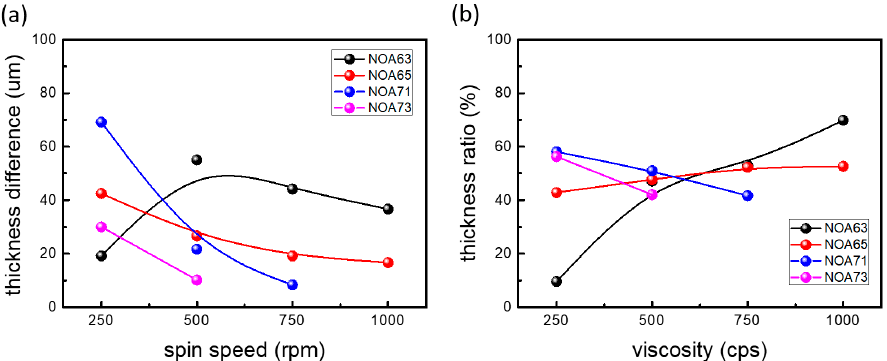
Figure 5. ( a ) Thickness deviation and ( b ) thickness ratio of silver nanowire flexible electrodes embedded in different NOAs.